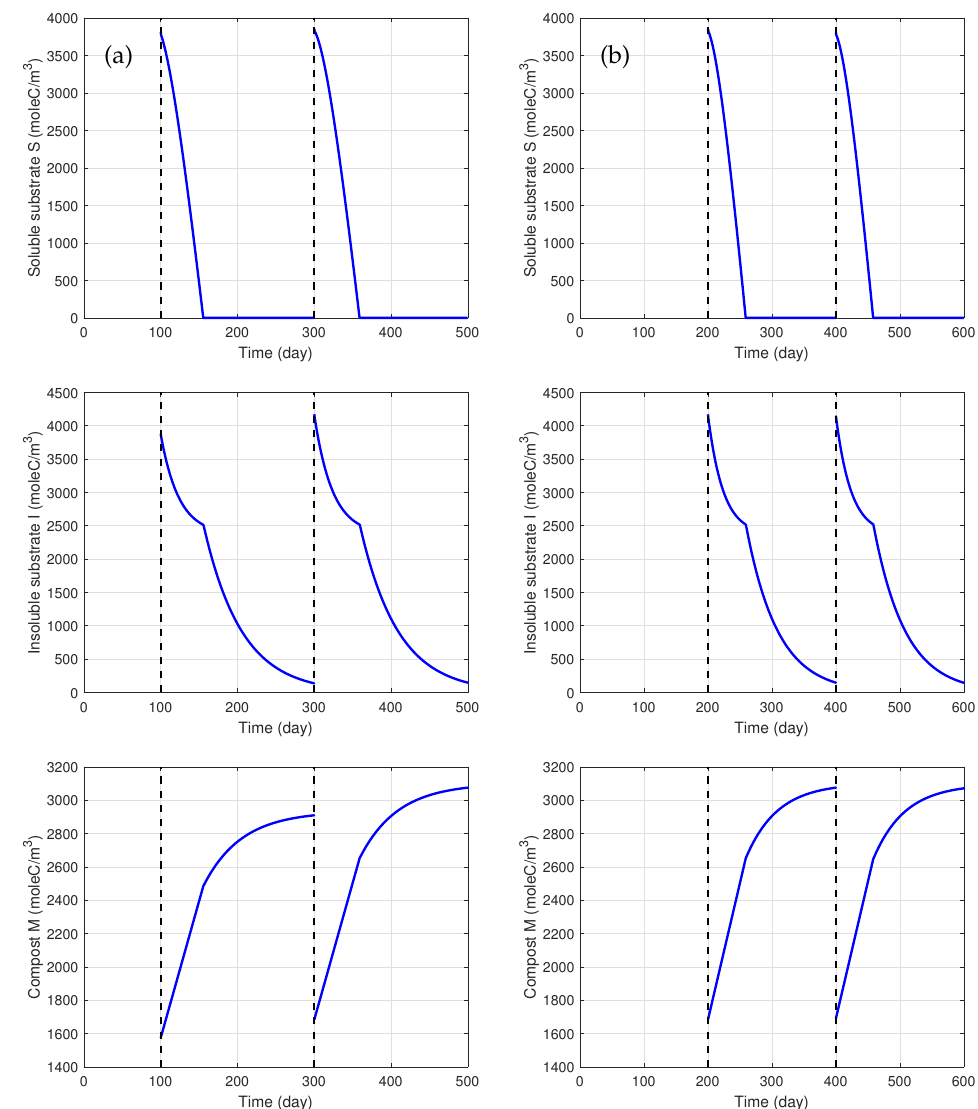
Figure 12. Composting process: Soluble substrate, insoluble substrate, inert material (compost) in